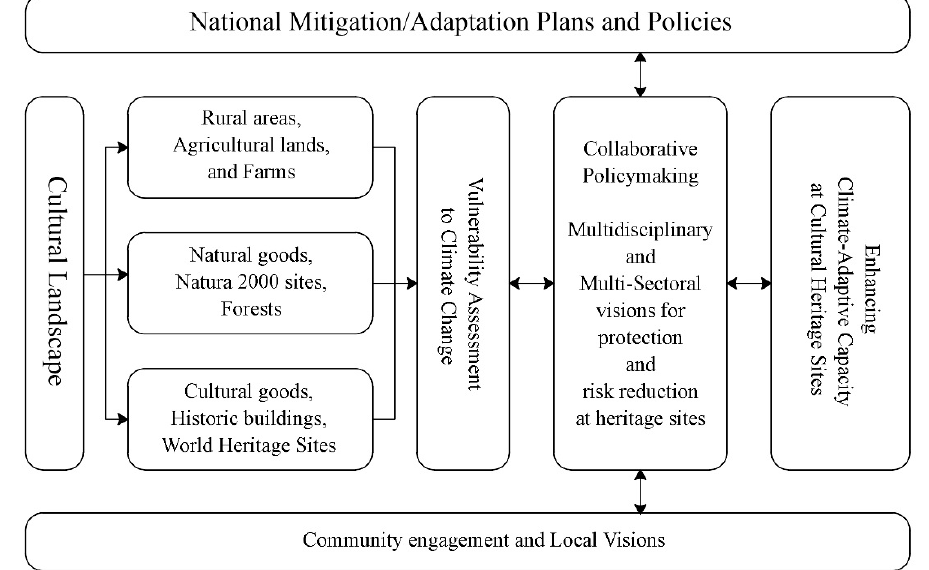
Figure 4. A framework for building adaptation capacity and sustaining of cultural landscapes in Central Italy.